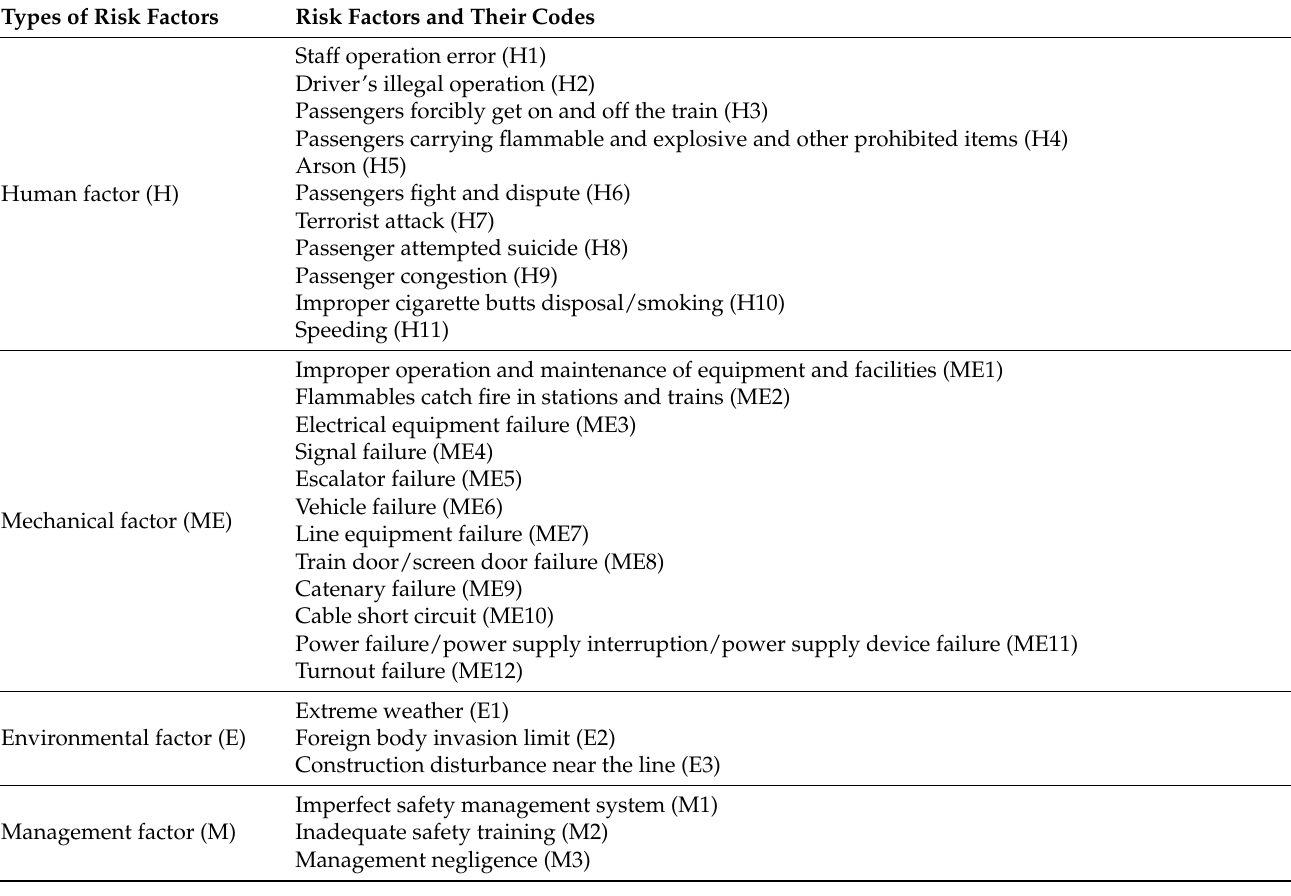
Table 3. Spindle coding of accident risk